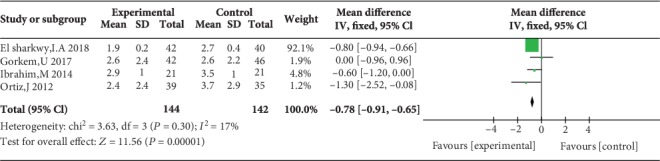
Postoperative pain scores at rest at 12 h.